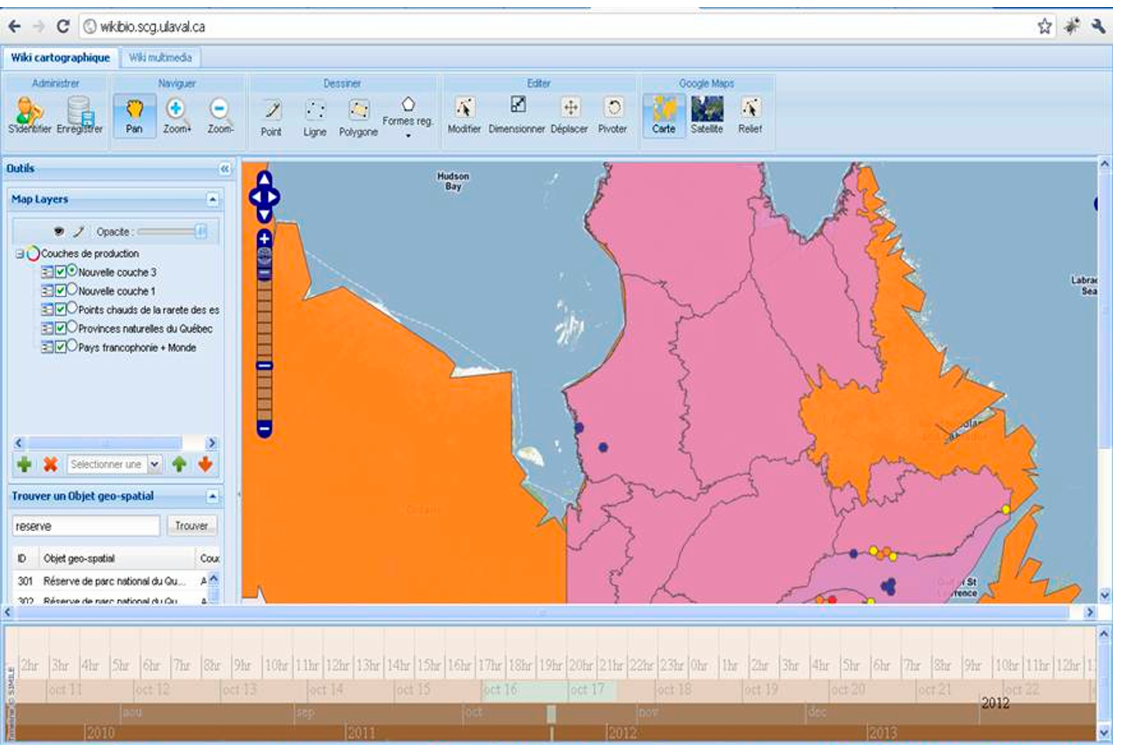
Figure 7. Cartographic interface of